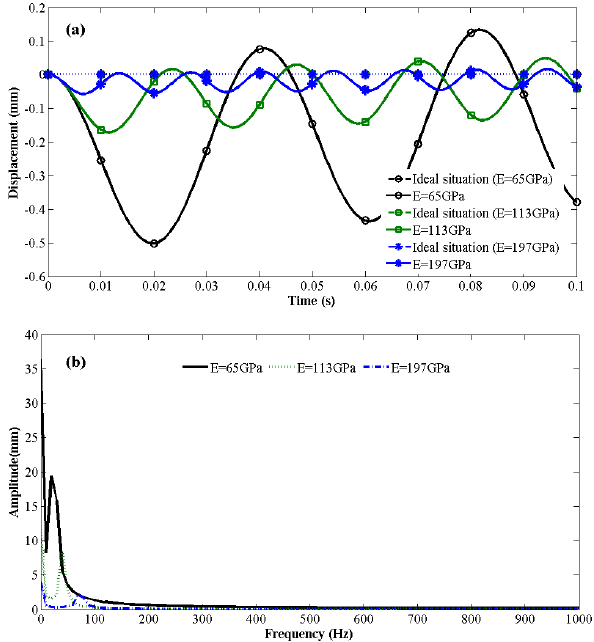
Figure 8. Effect of Young’s modulus on the vibration responses of the MDFMS: (a) response amplitudes and (b) response